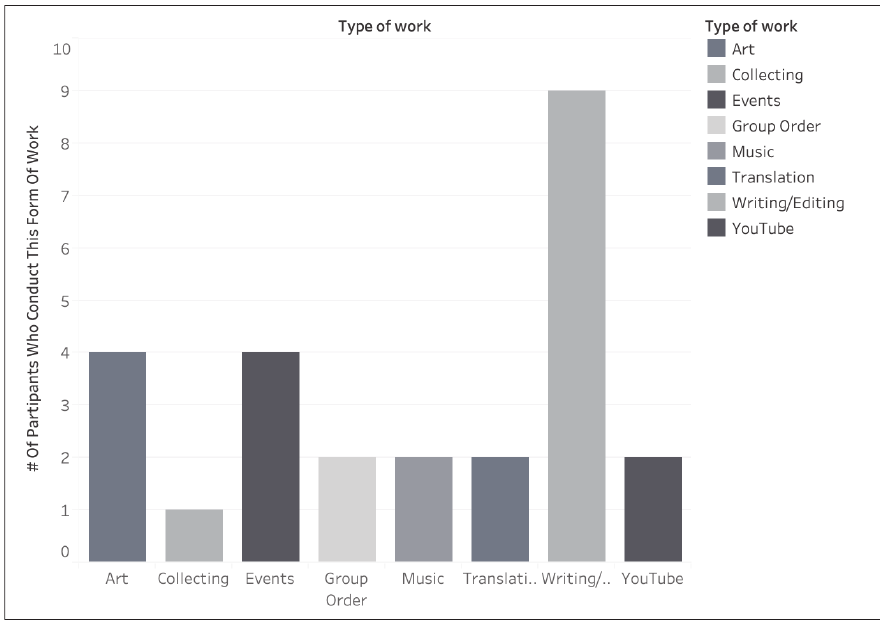
<Figure 1> Varying degrees of fan work in ARMY